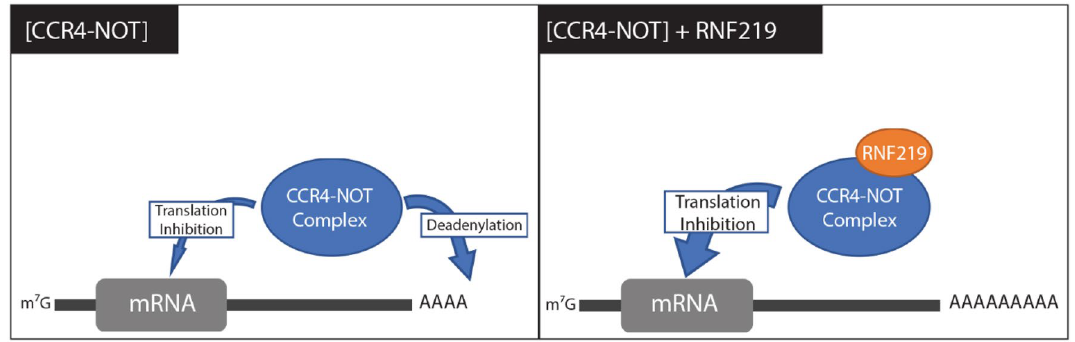
Figure 6. Endogenous RNF219 is implicated in cell cycle regulation. ( A ) Knock-down of RNF219 induces an increase in p27 protein level. HeLa cells were transfected with two siRNA against RNF219 (CDS and UTR) or CNOT3. RNF219, CNOT3 and p27 protein levels were analyzed by immunoblotting using RNF219-A, CNOT3 and p27 antibodies respectively. ( B ) Knock-down of RNF219 does not substantially affect p27 mRNA level. RNA was extracted in control (SCR) or in RNF219 depleted cells (CDS). RT-QPCR was performed using primers specific to p27/CDKN1b (Table S1) and was normalized on 18S mRNA level. p27/CDKN1b mRNA level was set to 1 in the control (SCR). Error bars represent SD, n = 3. ns P > 0.05 based on unpaired two-tailed Student’s t test. ( C ) Volcano plot showing differentially expressed (DE) genes of two replicates between siRNF219 CDS versus control SCR. Blue dots represent genes upregulated in RNF219 depleted cells, red represent downregulated genes, black signifying non-DE genes. Differential expression threshold is BH corrected p-value < 0.05 and |LogFC| > 0.5. ( D ) The top 10 downregulated (red) and upregulated (blue) GO Biological Process terms using gene set enrichment analysis comparing siRNF219 CDS versus SCR. All enrichments are significant with a BH corrected p-value < 0.001.